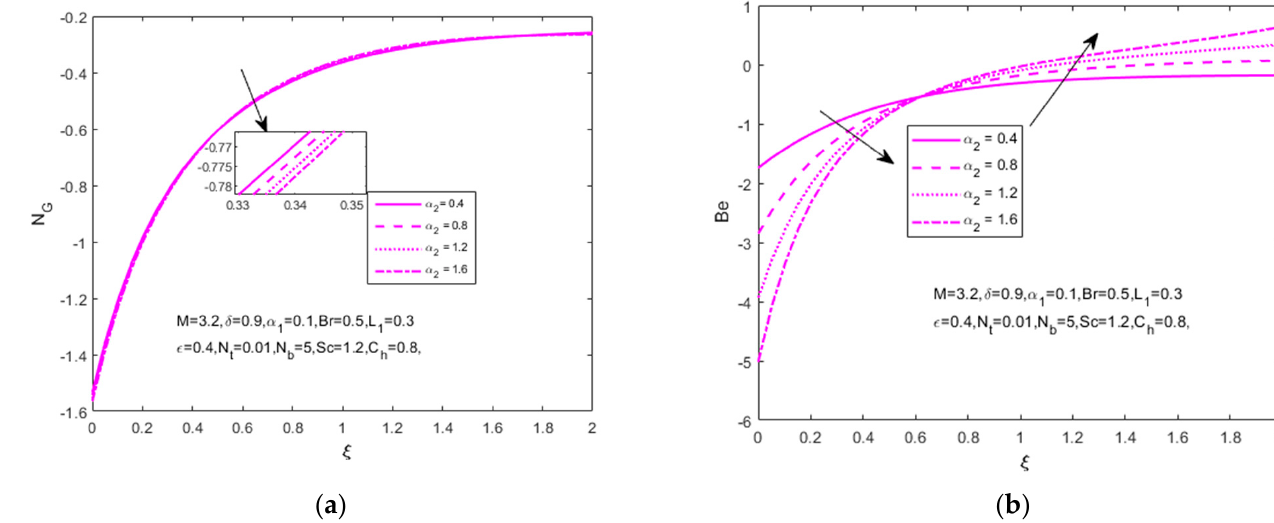
Figure 9. Impact of chemical reaction parameter C h on ( a ) velocity ( F (cid:48) ( ξ )) and ( b ) concentration h ( Φ ( ξ )) , respectively. The influence of the concentration difference parameter ( α 2 = 0.4, 0.8, 1.2, 1.6 ) , dimen- ) N sionless parameter ( L 1 = 0.2, 0.4, 0.8, 1.6 ) , and fluid parameter δ ( 1, 3, 6, 9 ) on the entropy G generation and Bejan number are shown in Figure 10a–e. The degree of energy generation ( N ) decreases at a stretching surface where the concentration gradient increases. The G Bejan number ( Be ) decreases at one frequency surface and increases towards the other frequency where a reaction occurs in the internal heat and fluid viscosity.